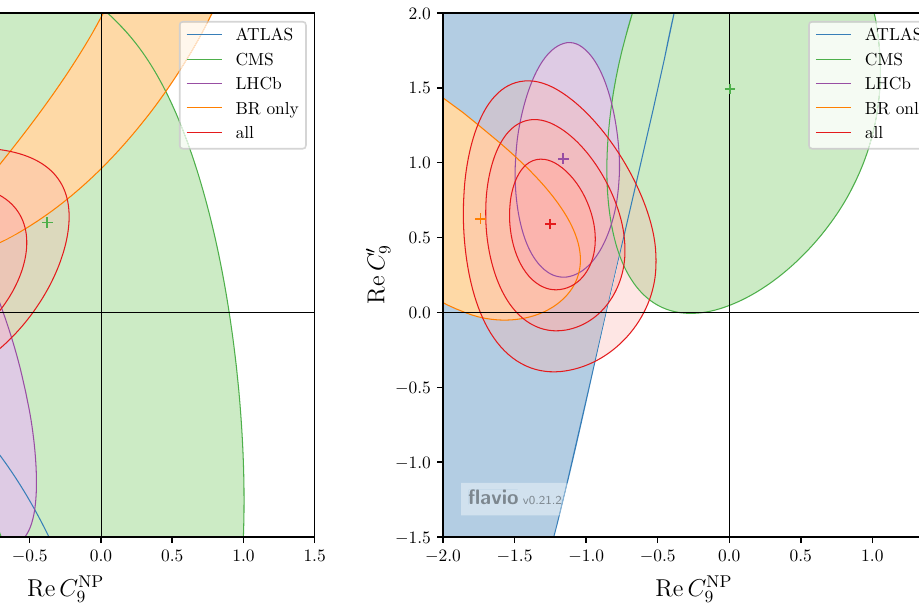
Fig. 1 Two-dimensional constraints in the plane of NP contributions to the real parts of the Wilson coefficients C 9 and C 10 ( left ) or C 9 and C (cid:4) ( right ), assuming all other Wilson coefficients to be SM-like. For 9 the constraints from the B → K ∗ μ + μ − and B s → φμ + μ − angular